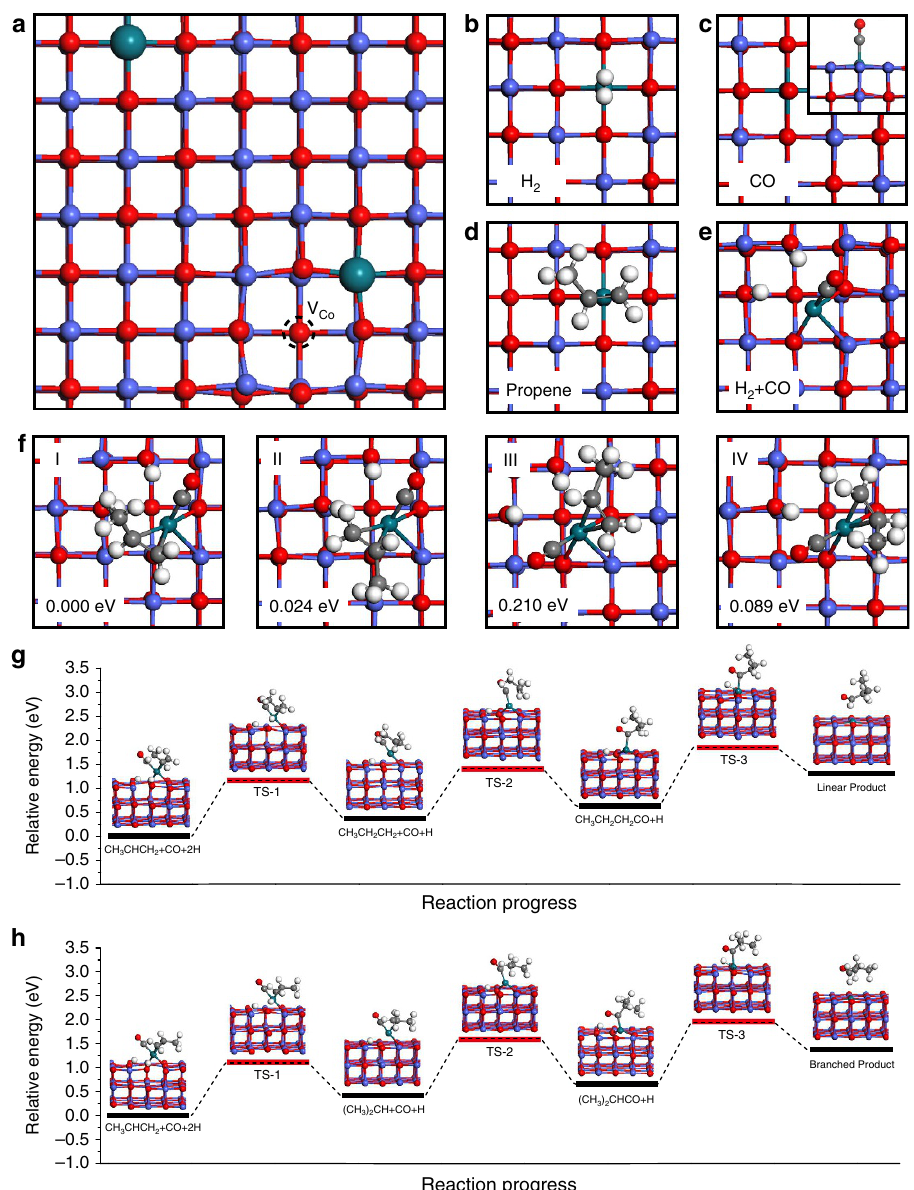
Figure 4 | DFT calculations of Rh 1 /CoO in the hydroformylation of propene. ( a ) The model of Rh 1 /CoO. Two Rh atoms occupy the position of two Co atoms, together with the involvement of a Co vacancy. ( b – d ) Top views of the adsorption configurations of H 2 , CO, and propene on Rh 1 /CoO, respectively. ( e ) Top view of the co-adsorbed configuration of both H 2 and CO. ( f ) Four co-adsorbed configurations of reactants and their corresponding adsorption energies. The most stable configuration I was taken as the energy standard ( D E ¼ 0.000eV). Adsorption energies of configuration II, III and IV were 0.024, 0.210 and 0.089eV, respectively. ( g , h ) Reaction paths deriving from configuration I and II,